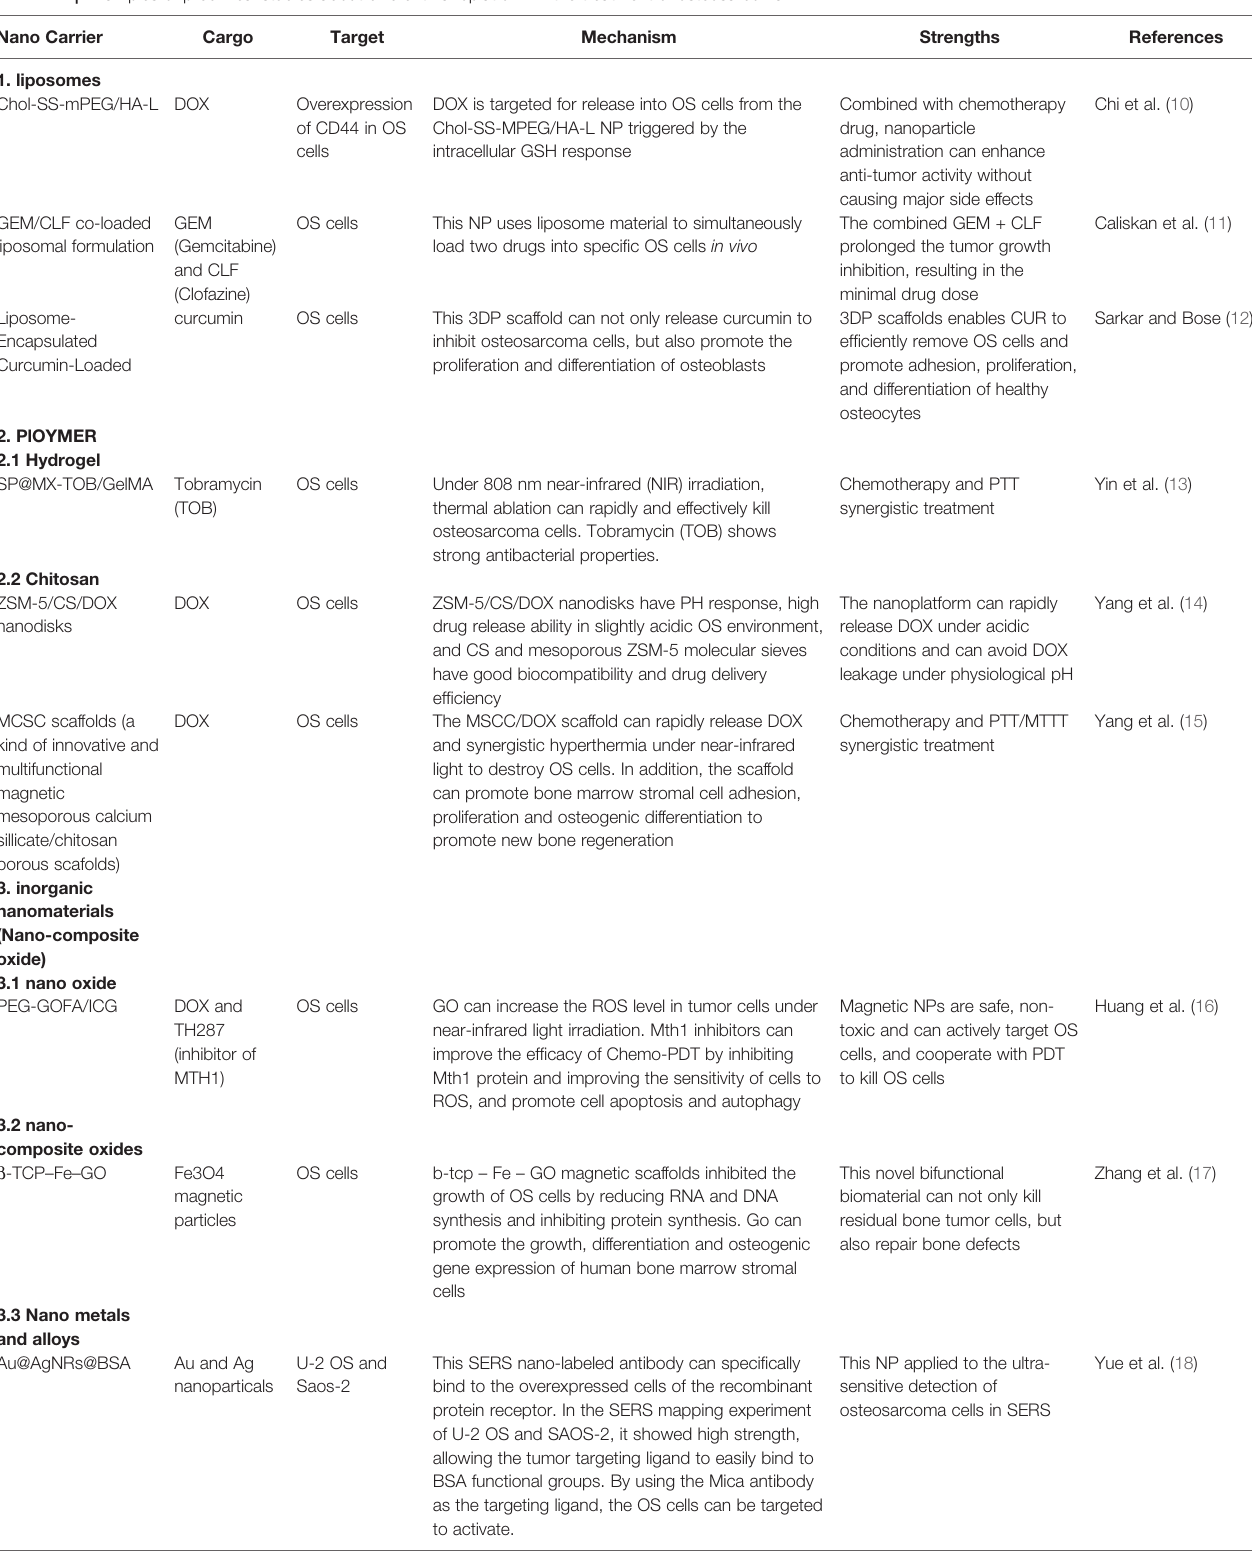
TABLE 1 | Examples of preclinical studies about different nanoplatform in the treatment of